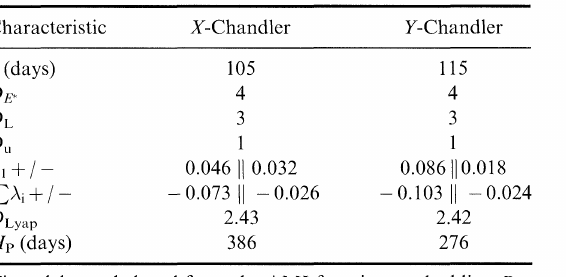
TABLE II Numerical characteristics of the nonlinear